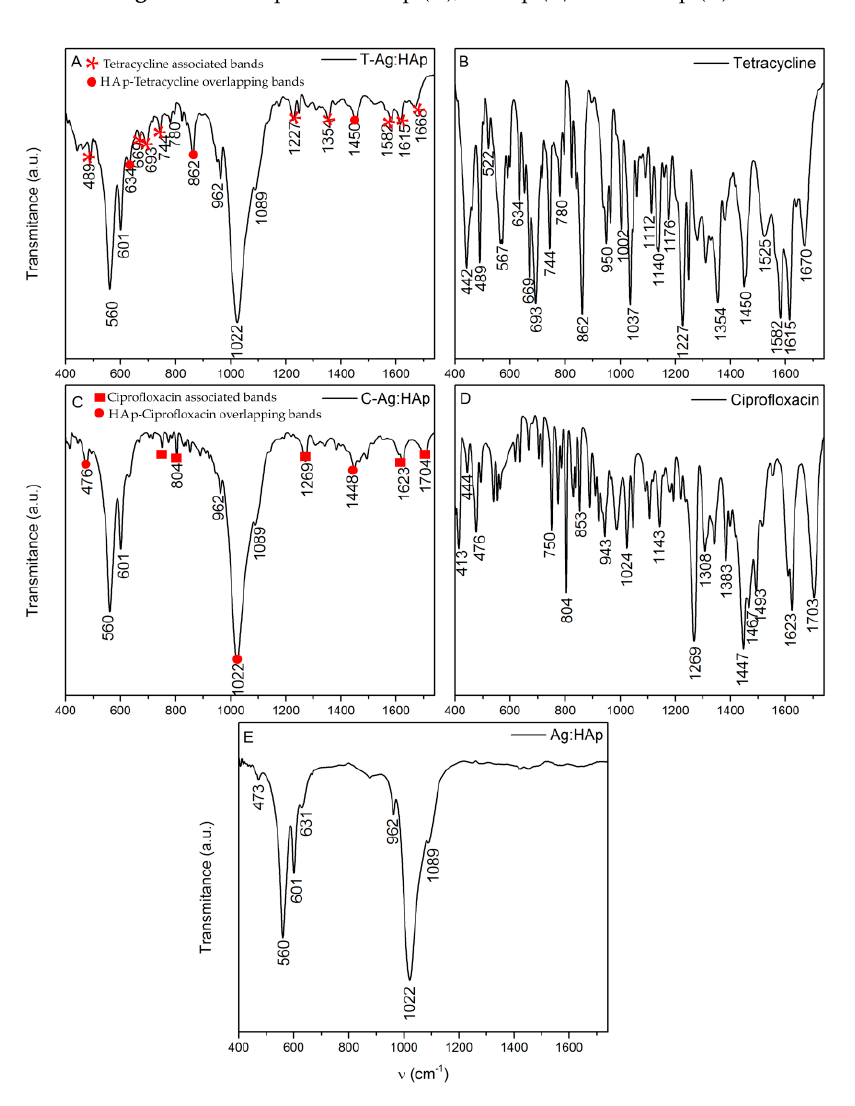
Figure 8. FTIR spectra of Ag:HAp ( E ), T-Ag:HAp ( A ) and C-Ag:HAp ( C ), as well as the spectra of the two antibiotics, Tetracycline ( B ) and Ciprofloxacin ( D ).